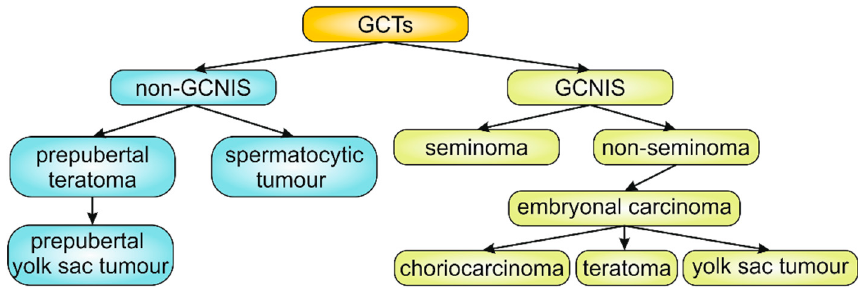
Figure 1. Main types of testicular cancer (TC). GCTs = germ cell tumours, GCNIS = germ cell neoplasia in situ.